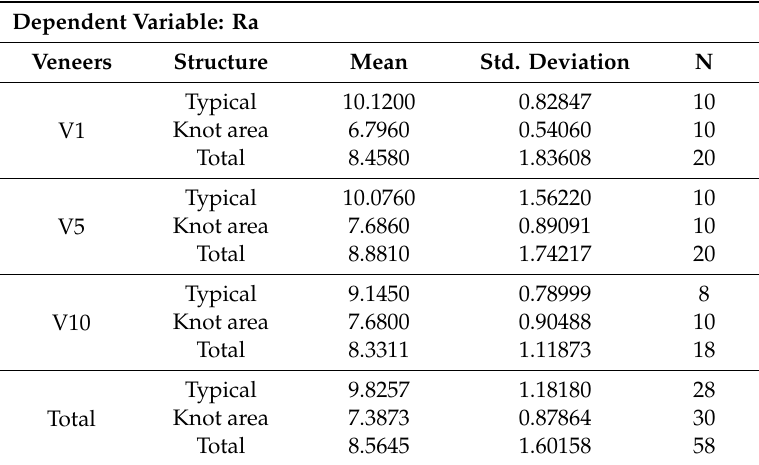
Figure 12. Surface roughness parameters Ra, Rz and Ry (µm) of cherry wood veneers (V1, V5, V10) on typical wood structure areas and around areas of irregular rings. Table 7. Descriptive statistics of dependent variable Ra measured on cherry veneers of typical wood structure areas and areas around areas of irregular rings.